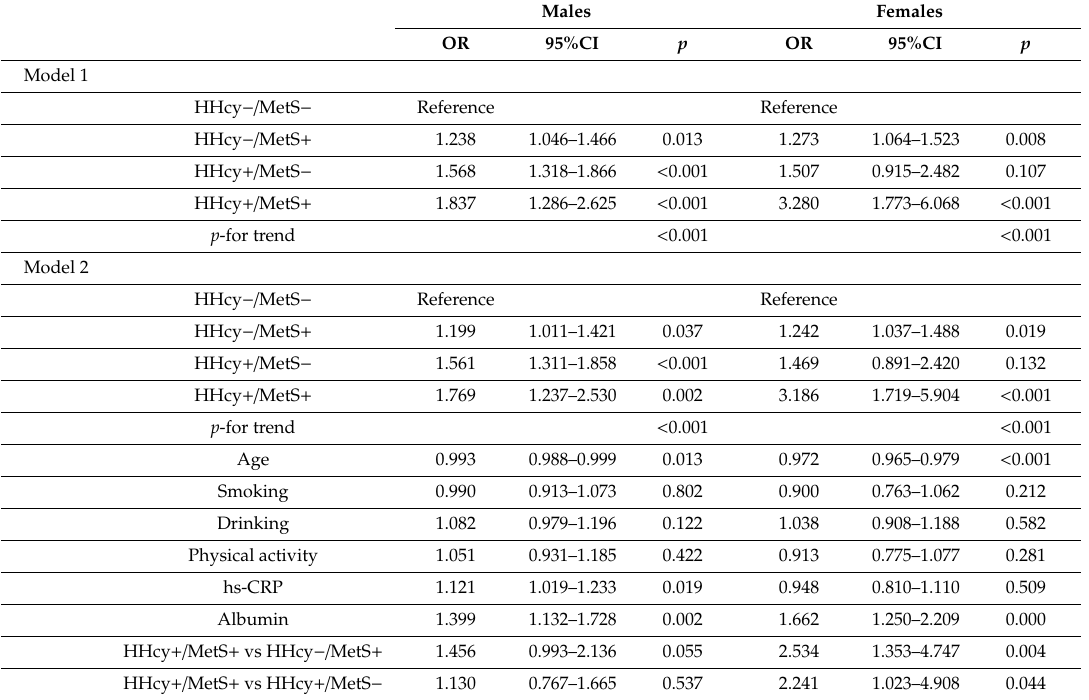
Table 4. Odds of albuminuria for the presence or absence of HHcy and MetS. Males Females